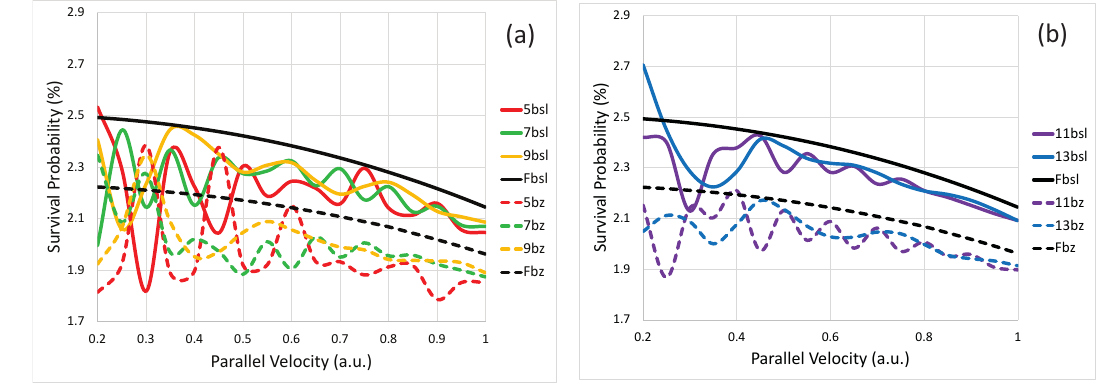
Parallel Velocity (a.u.)